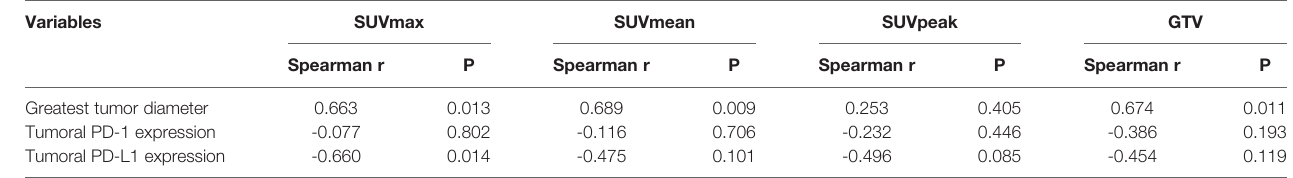
TABLE 3 | Correlation with 18 F-RGD uptake and greatest tumor diameter and tumoral PD-1/PD-L1 expression by IHC staining in patients. Variables